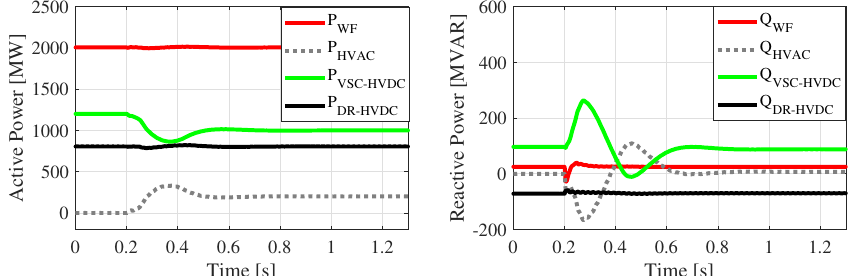
Figure 9. Active ( left ) and reactive ( right ) power of OWF and transmission lines when the HVAC link re-connects.